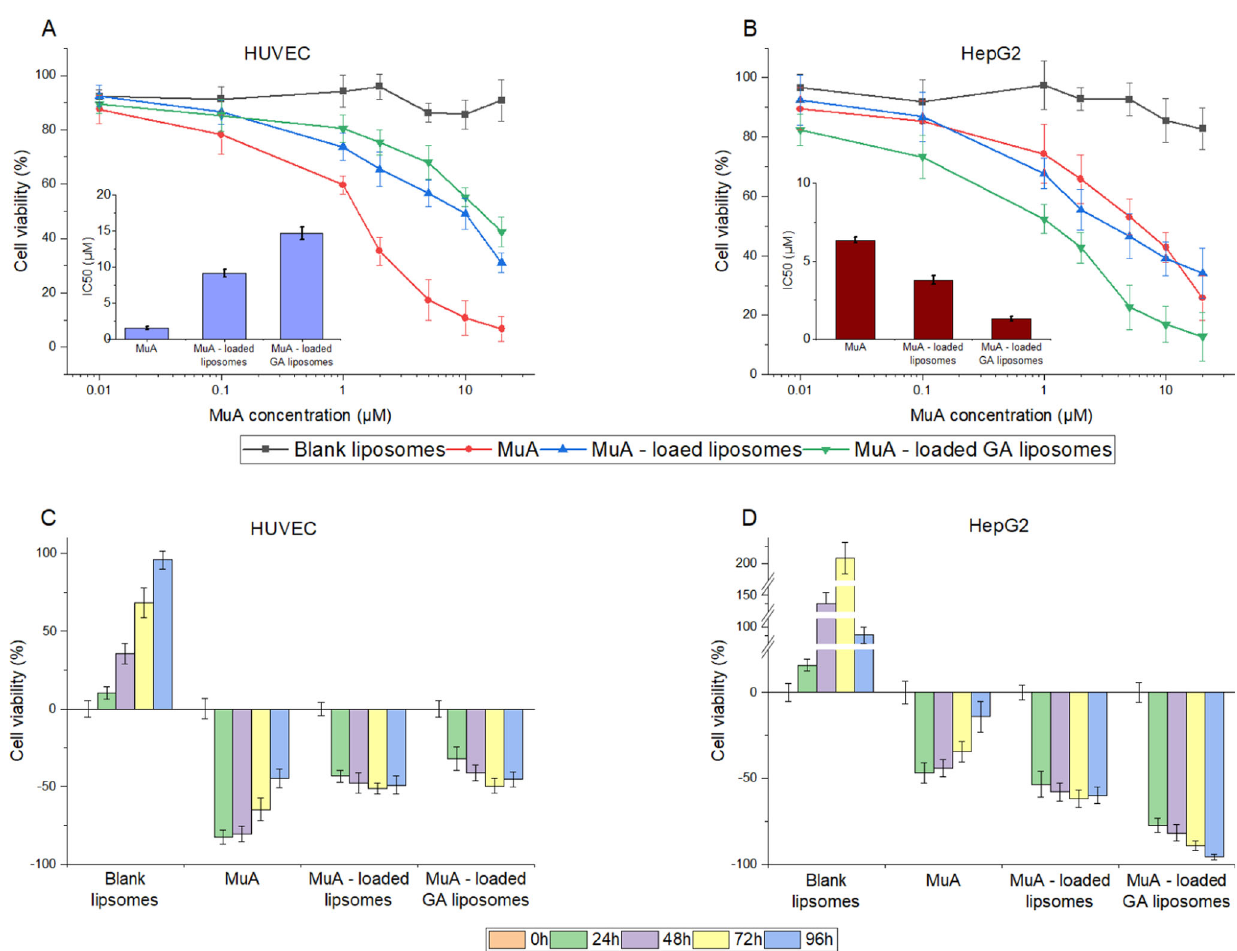
Fig. 4 The cytotoxicity of various liposomes against HUVEC and HepG2 cells. The IC 50 values of treatment with various formulations of MuA- loaded liposomes in HUVEC cells ( A ), HepG2 cells ( B ). Cell viability after treatment with various formulations of MuA-loaded liposomes in HUVEC cells ( C ), HepG2 cells ( D ); Data are presented as the mean ± SD ( n =